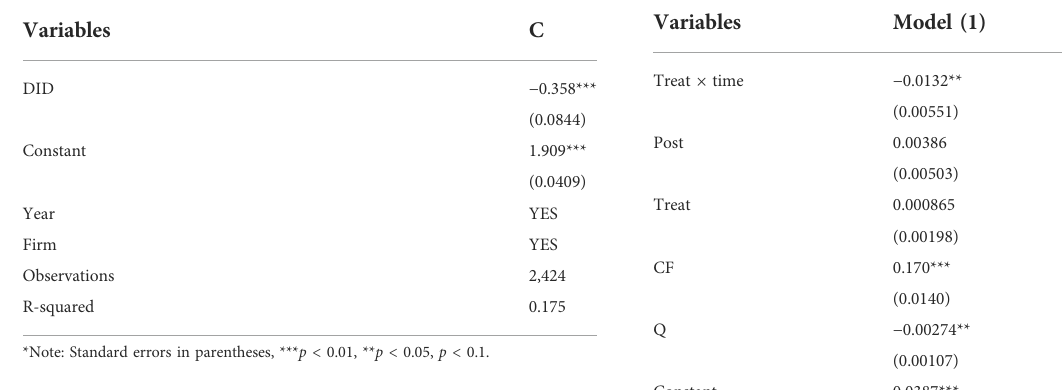
TABLE 7 Regression results of carbon constraints and fi nancial distress. TABLE 8 Regression results of carbon constraint and